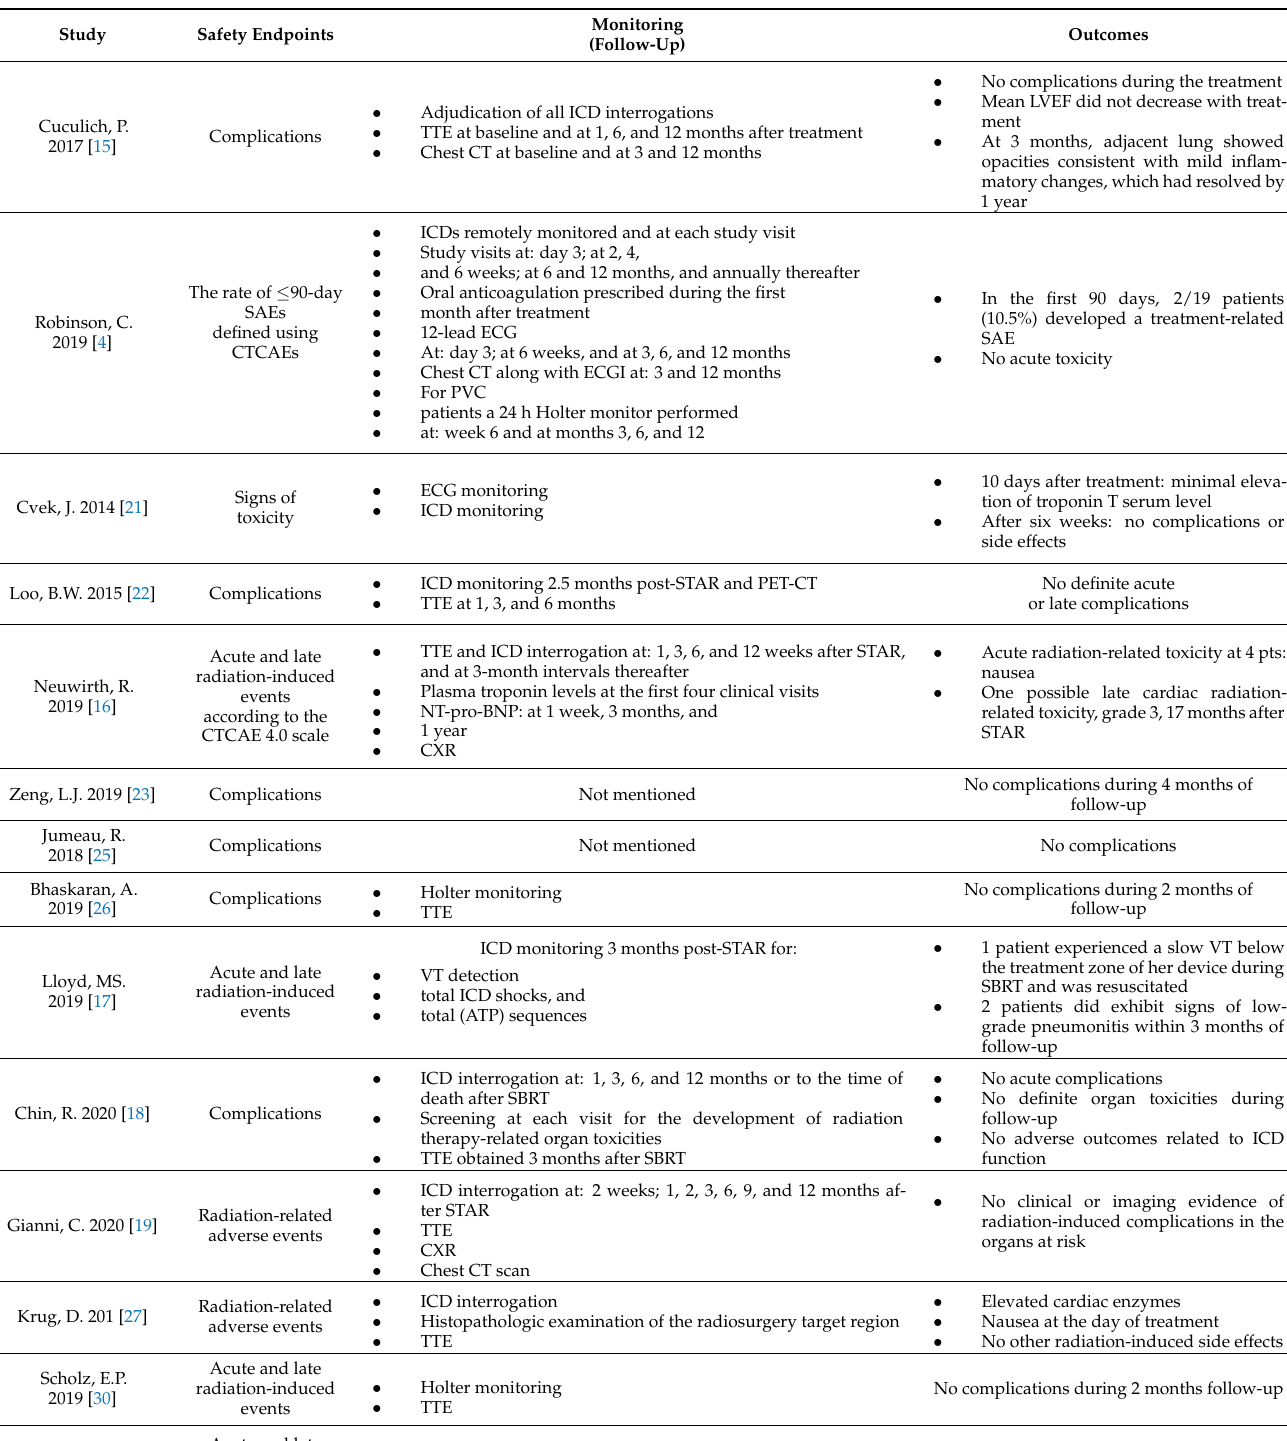
Table 2. Safety end points and the corresponding monitoring methods for the patients of each